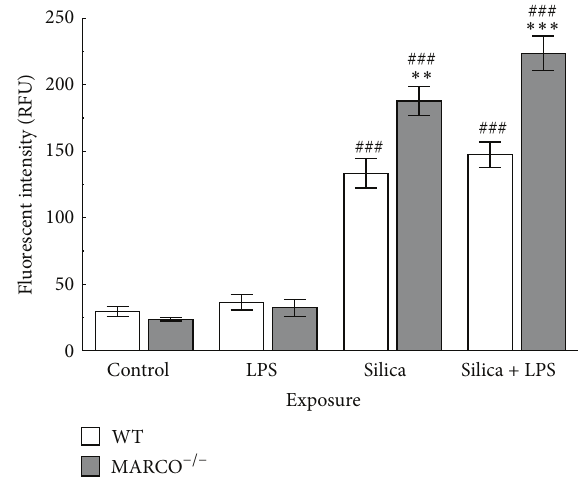
Figure 4: Caspase-1 activation in MARCO −/− and WT AM exposed to silica. Caspase-1 activation in WT and MARCO −/− AM was measured 4 hrs after treatment with silica (100 𝜇 g/mL) with or without LPS (20ng/mL) as described in Methods. Mean ± SEM white bars indicate WT AM and grey bars indicate MARCO −/− AM. Doubleasterisk ∗∗ indicates 𝑃 < 0.01 andtripleasterisk ∗∗∗ indicates 𝑃 < 0.001 compared to WT at corresponding treatment. ## indicates 𝑃 < 0.01 compared to control in the same mice strain. 𝑛 = 3 per experimental